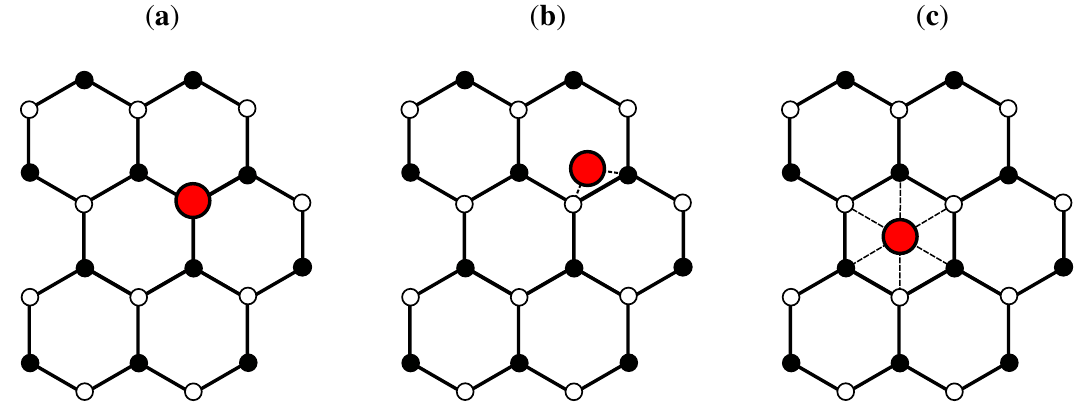
Figure 7. The three types of impurity configuration discussed: ( a ) substitutional atom; ( b ) bridge-adsorbed atom and ( c ) plaquette